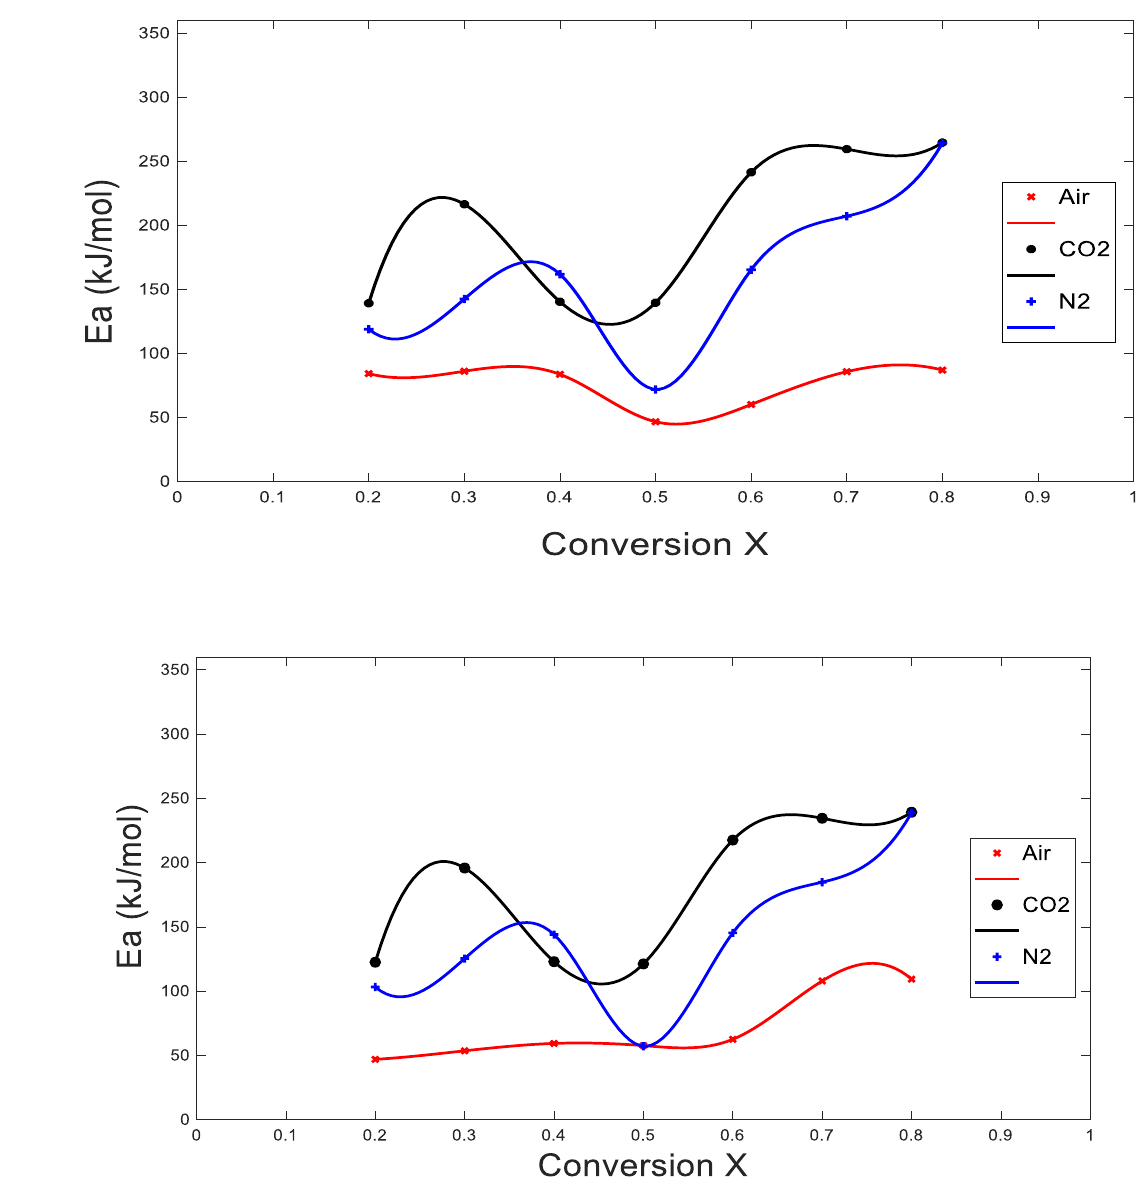
Figure 6. Compression plots of E a as a function of conversion ( X ) : ( a ) OFW and ( b ) KAS.